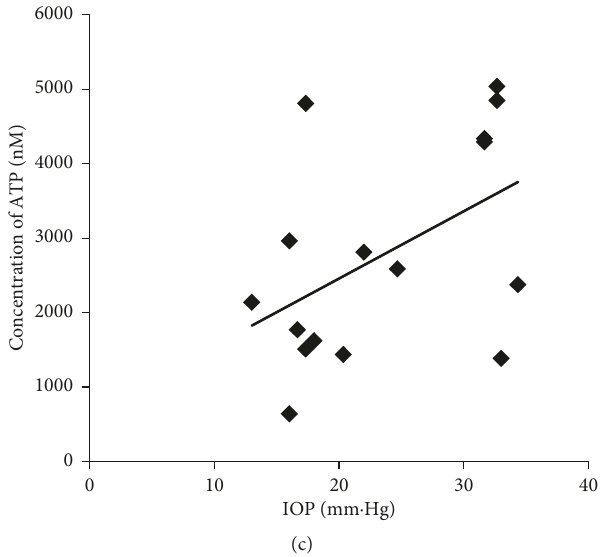
Figure 4: The correlation between intraocular pressure (IOP) and ATP concentration in the retinas of rats with ocular hypertension and normal tension. (a) Averages of IOPs for ocular hypertension (OH, n � 8) and normotension (NT, n � 8) are shown with bars representing the standard deviation ( ∗ p < 0 . 01, t -test). (b) Averages of ATP concentrations in the retina are shown with bars representing the standard deviation ( ∗ p < 0 . 01, t -test). (c) Intraocular pressure (IOP) and concentration of ATP of all eyes ( n � 16) were dot blotted. The line is the mean regression